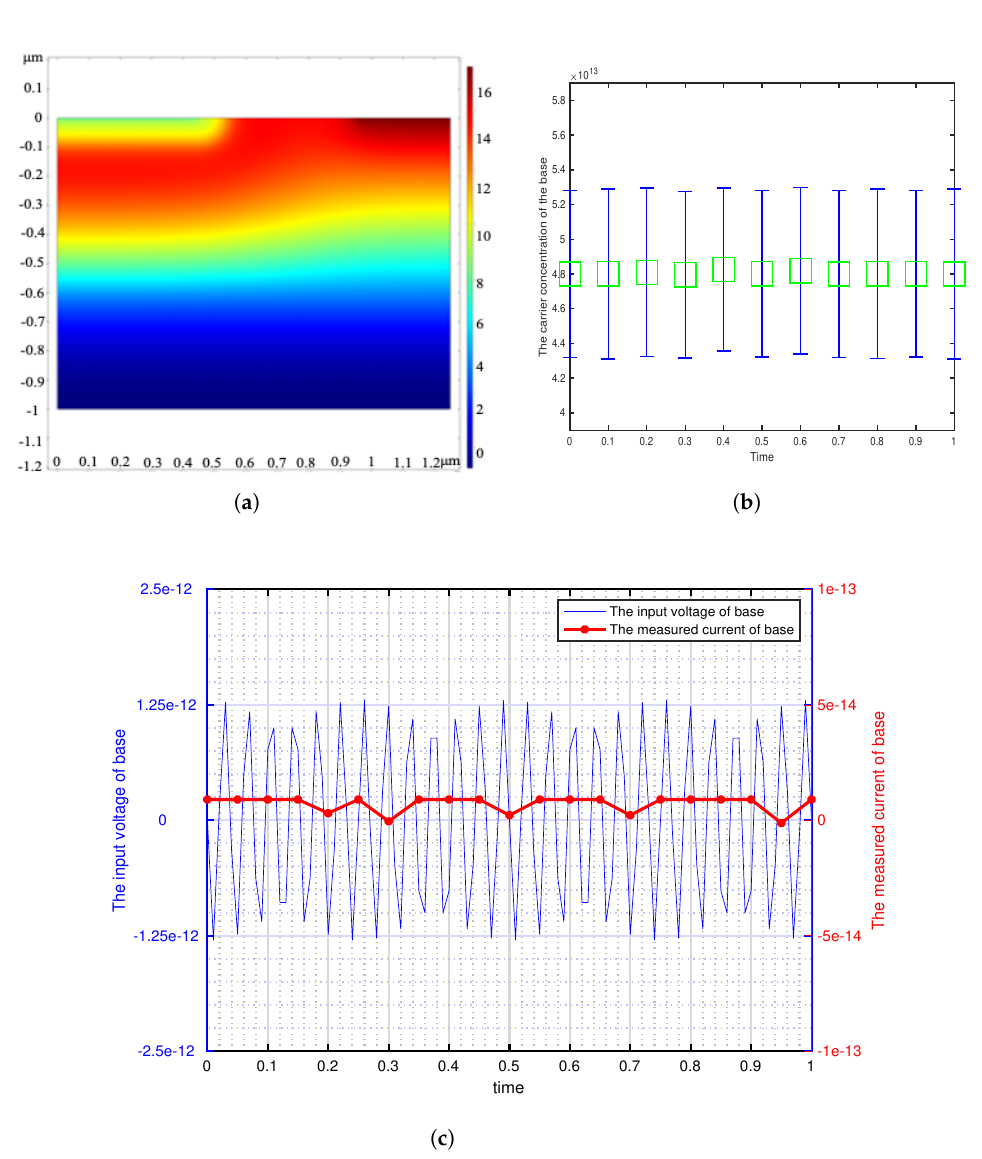
Figure 6. The corresponding sinusoidal voltage signal is applied to the bipolar transistor in the amplification region, which is made of impurity germanium(Ge-2) with doping concentration of 4.8 × 10 13 cm − 3 and carrier lifetime of 5 × 10 − 5 s. ( a ) The potential distribution of the intrinsic semiconductor under sinusoidal small voltage signal. (2-D front view) ( b ) The variation of base carrier concentration with time. ( c ) The input weak sinusoidal voltage signal and corresponding base current